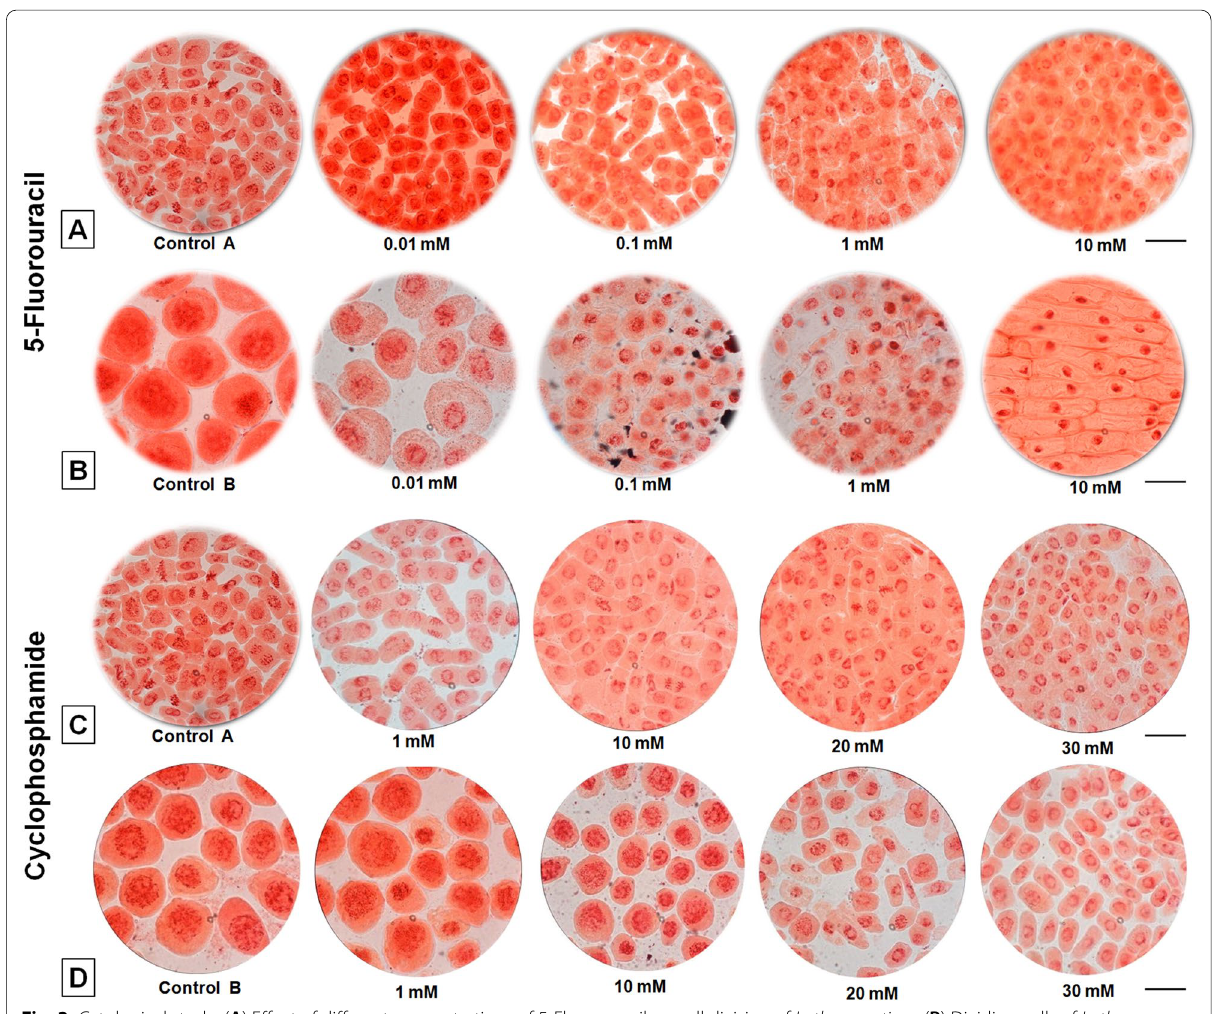
Fig. 3 Cytological study: ( A ) Effect of different concentrations of 5-Fluorouracil on cell division of Lathyrus sativus . ( B ) Dividing cells of Lathyrus sativus treated with colchicine followed by different concentrations of 5-Fluorouracil. ( C ) Effect of different concentrations of cyclophosphamide on cell division of Lathyrus sativus . ( D ) Dividing cells of Lathyrus sativus treated with colchicine followed by different concentrations of cyclophosphamide. Control A (seeds soaked in distilled water) treatments showing cessation of dividing cells. Control B (seeds soaked in 0.5% colchicine for 8 h) demonstrating dividing polyploid cells; treatments showing cessation of polyploid